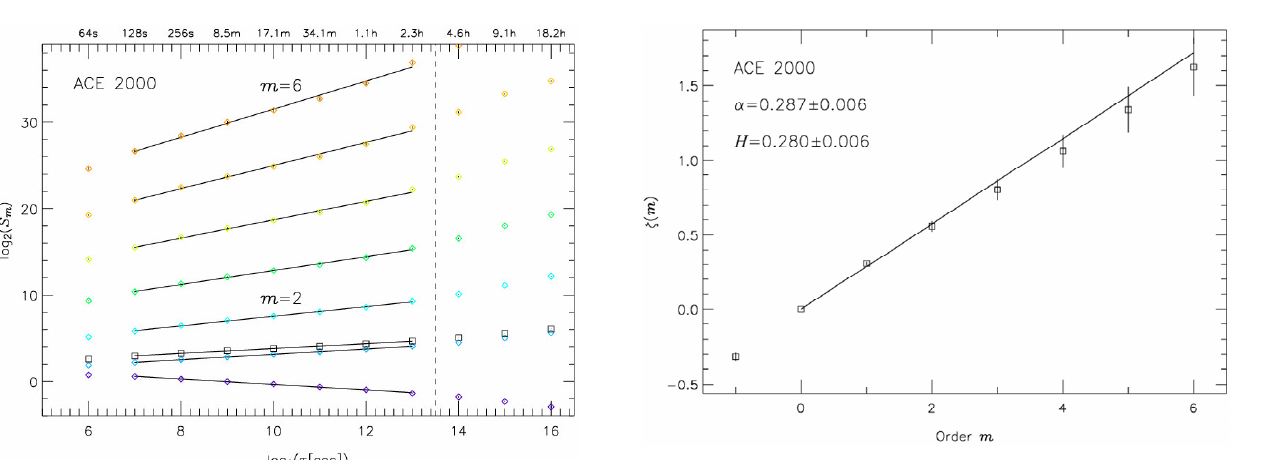
Fig. 8. A generalised structure function (GSF) analysis showing the variation of the moments S m ( τ) = h| δ v sw ( t, τ ) | m i with tempo- ral scale τ for orders m =− 1 to 6, but not the trivial results for m =0. The results are quasi-linear on a log-log plot between τ =128s and ∼ 2h. We also show the variation of the standard deviation σ ( τ) =[ S 2 ( τ) ] 1 / 2 with τ (squares). The error bars are drawn at the 3 σ level, and weighted least squares fits have been applied to all the moments.